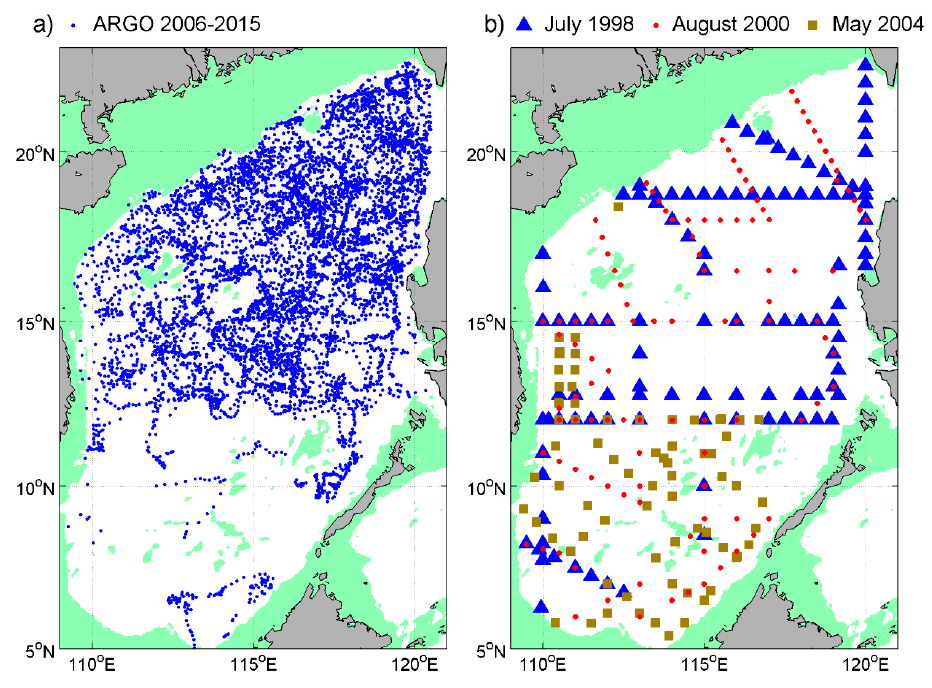
Figure 2. Distribution of ( a ) Argo measurements from 2006 to 2015 and ( b ) CTD data of three joint cruises investigation in July 1998 (blue triangles), August 2000 (red points) and May 2004 (golden squares).